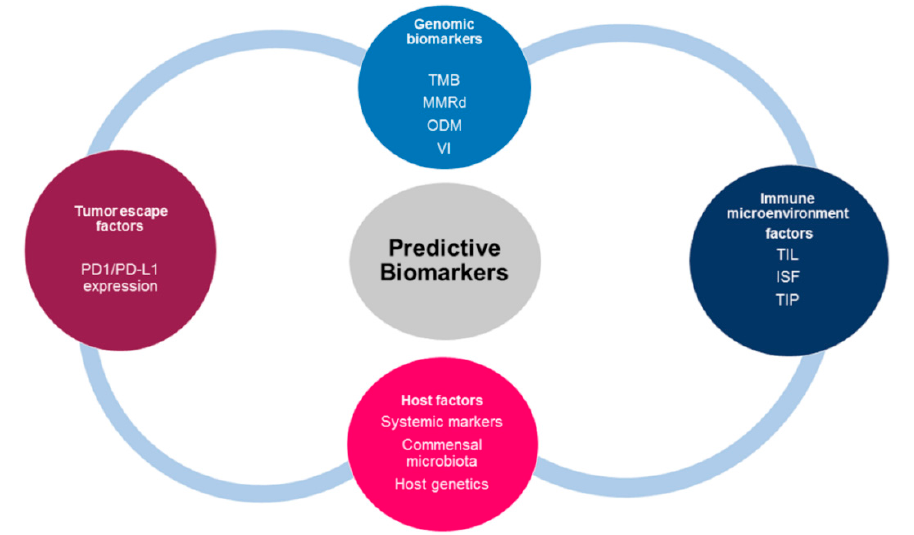
Figure 6. Emerging predictive biomarker of response to immune checkpoint inhibitor. The programmed cell-death 1 and its ligand (PD-1 / PD-L1) are tumor escape factors used widely as predictive biomarkers for patient’s response to immunotherapy. Other suggestive biomarkers include genomic, tumor-escape, immune-microenvironment and host factors. These factors include TMB (tumor mutation burden), MMrd (mismatch repair deficiency), VI (oncogenic viral infection), ODM (oncogenic driver mutation), TIL (tumor infiltrating lymphocyte), ISF (Immune suppressor factor) and tumor immune phenotype (TIP).